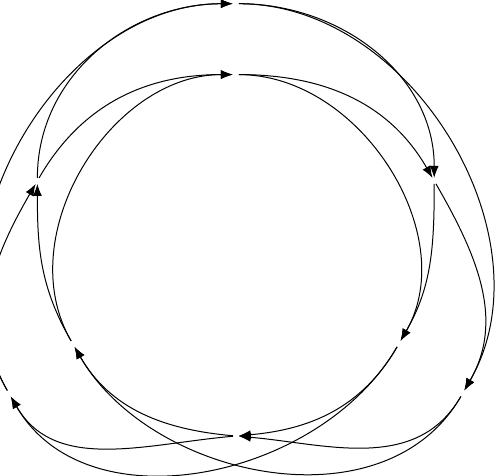
Figure 2. An alternate presentation of the response graph of Rock–Paper–Scissors, emphasising its Möbius strip